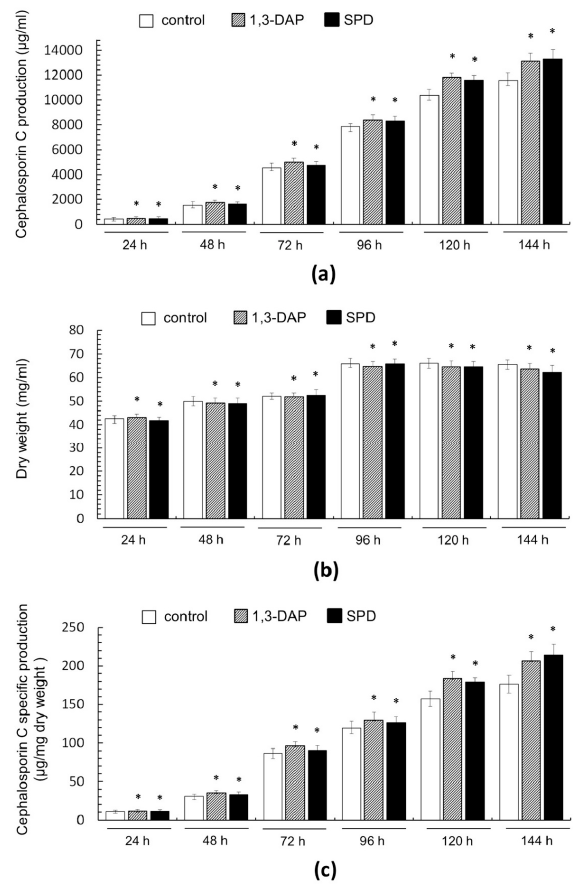
Figure 5. Effect of the addition of 5 mM 1,3-DAP or 5 mM spermidine (SPD) on cephalosporin C (CPC) production and growth of A. chrysogenum HY strain during fermentation on complex (CP) medium: ( a ) CPC production; ( b ) dry weight; ( c ) CPC specific production. Samples were taken at 24 h, 48 h, 72 h, 96 h, 120 h, and 144 h. Data are means ± SD, n = 3. Statistical significance, * p ≤ 0.05, as compared with the control (strain, cultivated on medium without PAs